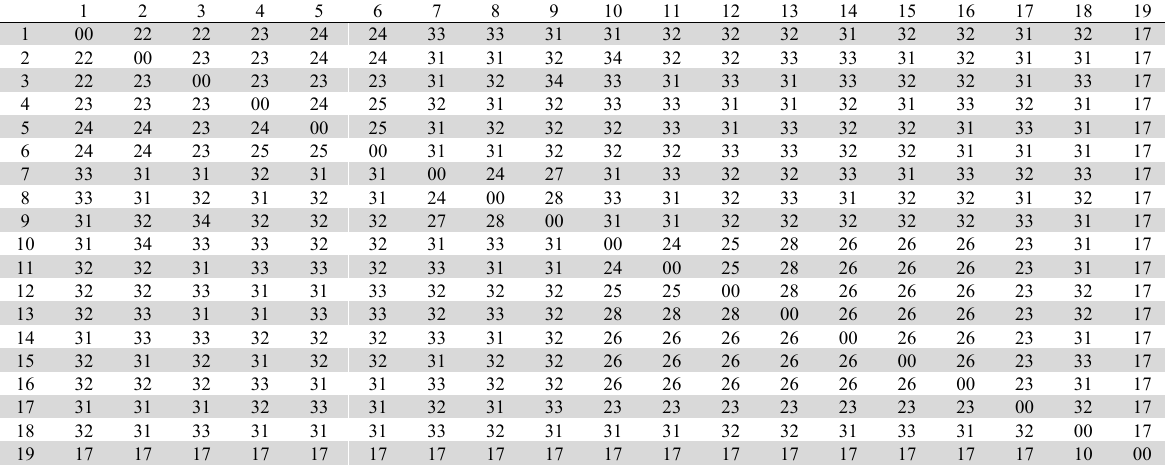
Cost for using transmission lines (USD/MW). P2P Model and INT models